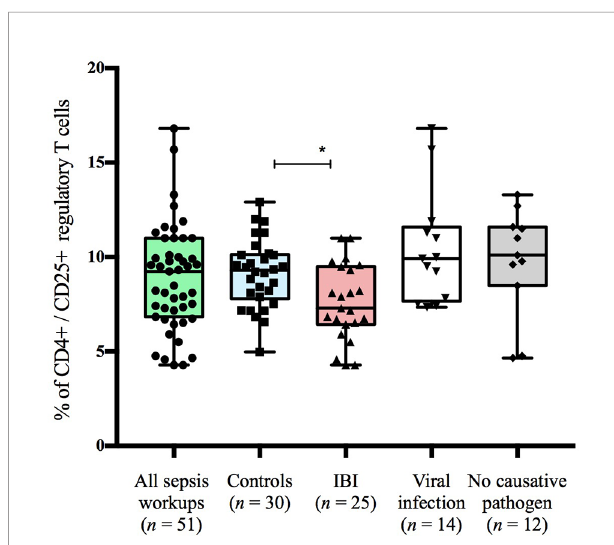
FIGURE 4 | Frequencies of CD4+FoxP3+regulatory T cells strati fi ed to subgroups of study cohort. Boxes are shown as median and IQR; *p-values were derived from Dunn ’ s multiple comparisons test (p <